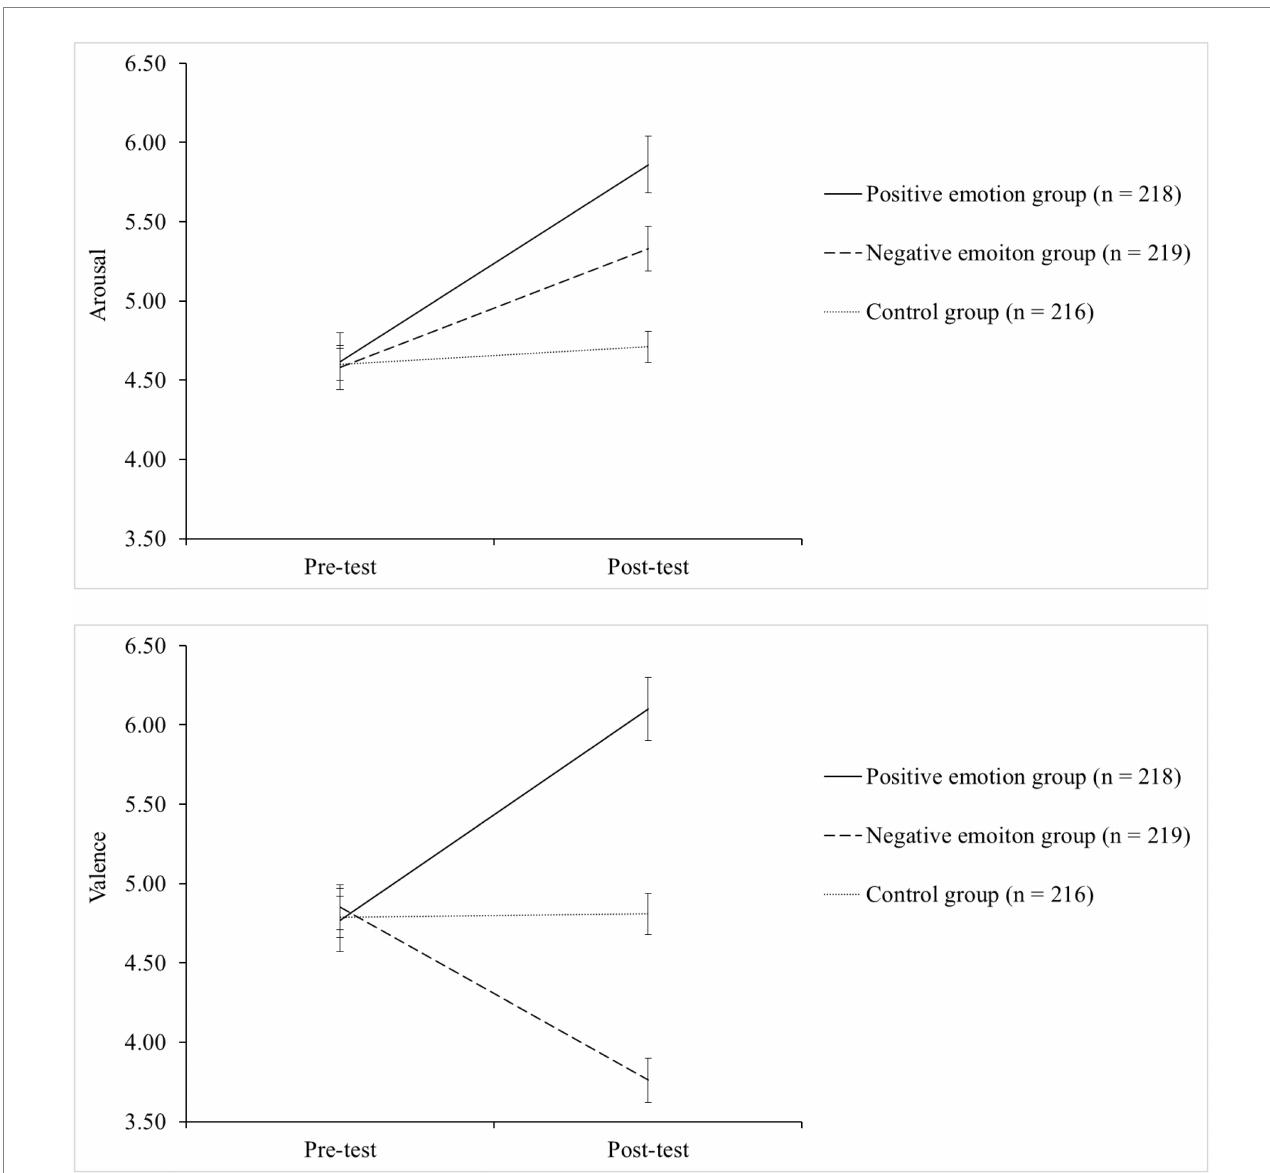
FIGURE 1 Changes in the arousal and valence scores between the pre-and post-test conditions for the three